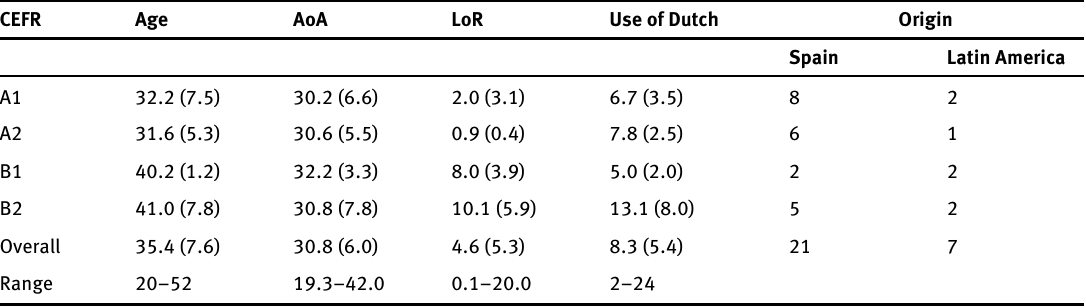
Table 2. Scores for speaker variables per CEFR language proficiency level; Age = age at the time of the recording, in years, AoA = age of arrival in the Netherlands, in years, LoR = length of residence in the Netherlands, in years, Use of Dutch = Self- estimated daily use of Dutch, in hours, Origin = where speakers were born and brought